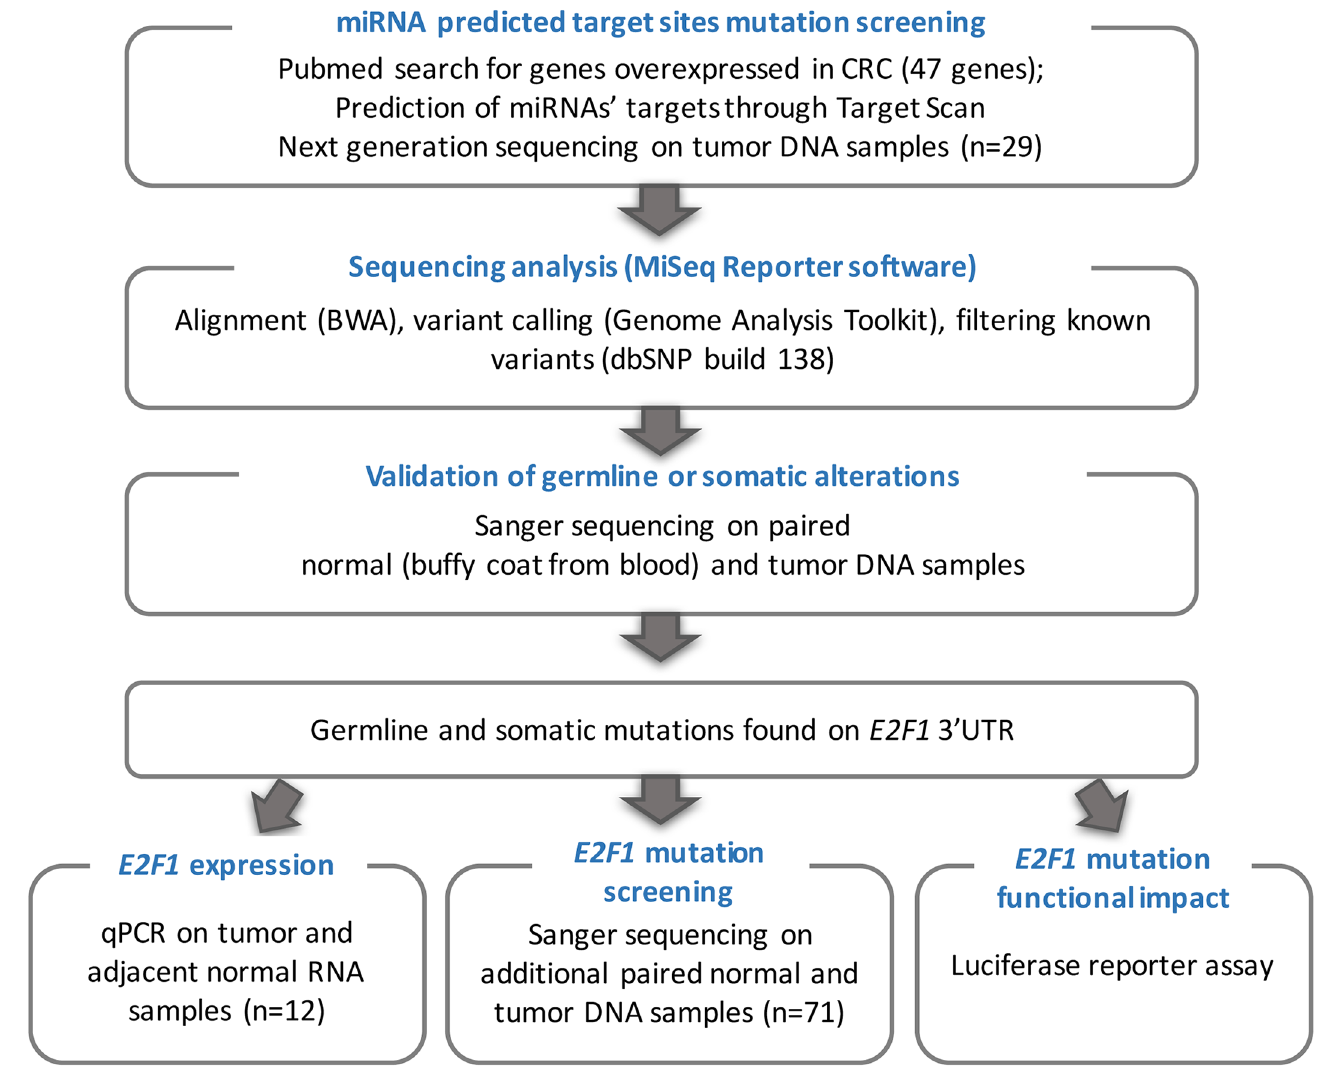
Fig 1. Study overview. BWA: Burrows-Wheeler